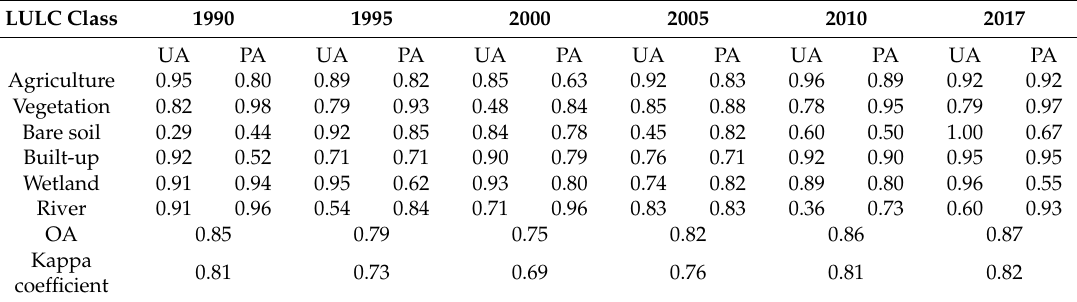
Table 6. Per-class accuracy assessments of multi-temporal RF